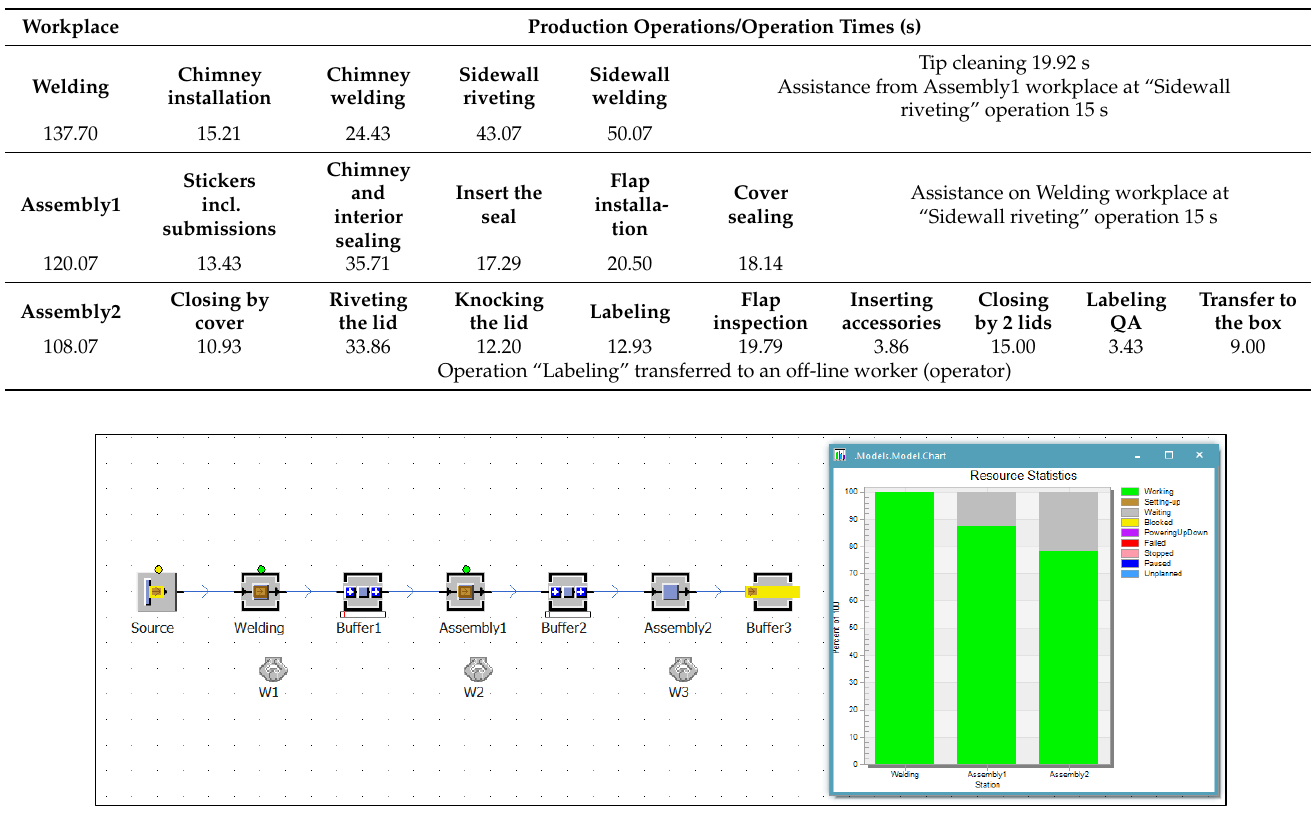
Table 1. The current state of production of TV160 — workplaces, production operations, and operat- ing times.